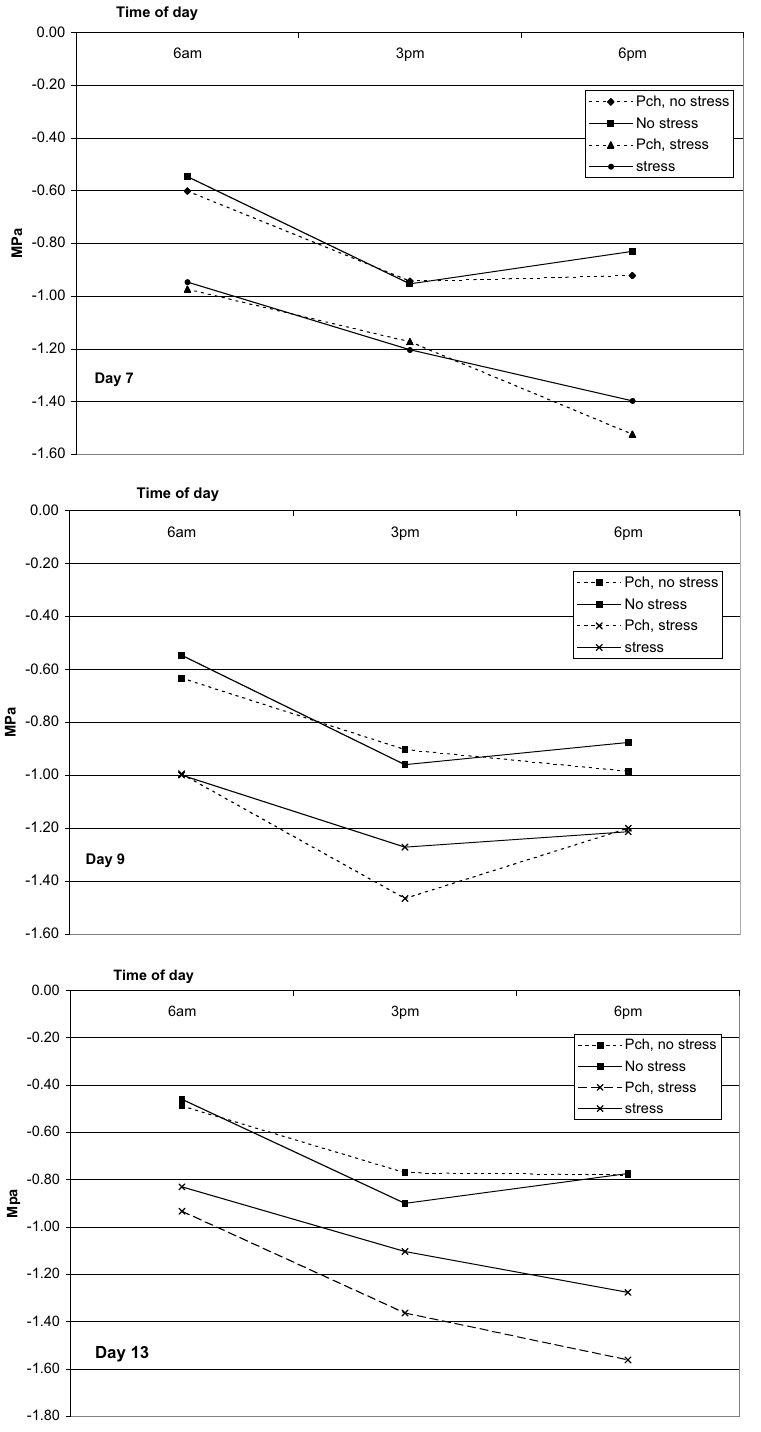
Fig. 8. Zinfandel, Year 2, 2005. Leaf water potential measured at 6 am, 3 pm and 6 pm on days 7, 9 and 13 after stress treatments